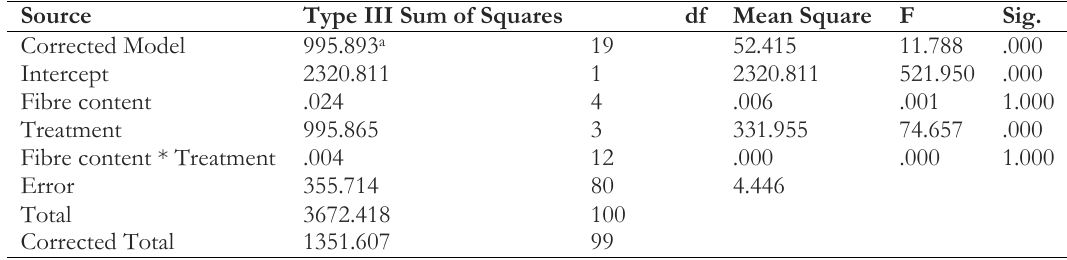
Table 7. Tests of between-subjects effects: dependent variable - moisture absorption.